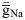
Spike threshold and corresponding biophysical basis produced by varying βm and g¯Na.(A)-(C) summarize the results produced by varying βm. The minimal model exhibits Type I excitability with βm = -8mV and Type II excitability with βm = -1mV. (D)-(F) summarize the results produced by varying g¯Na. The model exhibit Type I excitability with g¯Na=40mS/cm2 and Type II excitability with g¯Na=20mS/cm2. (A) and (D) show the activation curves and kinetics of ionic currents for two cell types. Increasing βm depolarizes Na+ activation m
∞ and produces no effects on w
∞ as well as τ
w. Decreasing g¯Na reduces the magnitude of Na+ conductance (data is not shown) without altering m
∞, w
∞ and τ
w. (B) and (E) give the membrane currents at the subthresholds for two types of neuron. Depolarizing Na+ activation m
∞ causes I
Na to be less strongly activated at the perithreshold potentials. Decreasing g¯Na reduces the I
Na intensity without altering its voltage-dependency and kinetics. Both of them result in a much larger outward I
SS at the threshold. (C) and (F) show the spike threshold as a function of dV/dt for two cell types. The dV/dt range is from 0.8mV/ms to 4.5mV/ms. For both cases, βw = -10mV, γw = 13mv, and other parameters are as indicated in Materials and Methods.